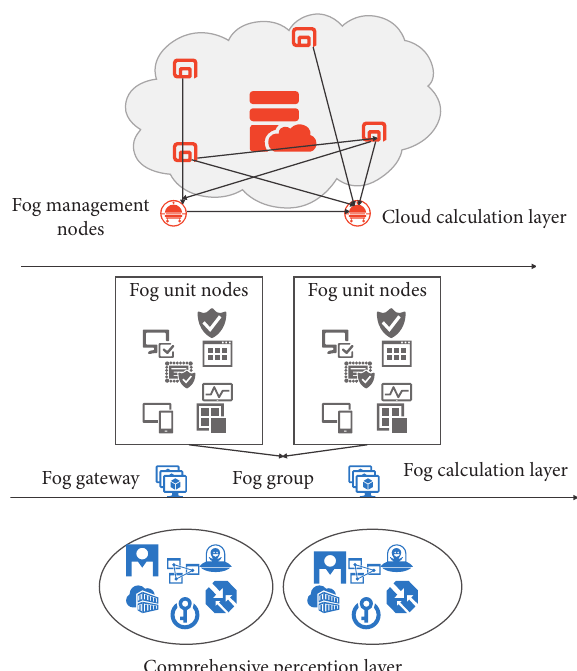
Figure 8: Intelligent manufacturing system for complex products driven by multisource